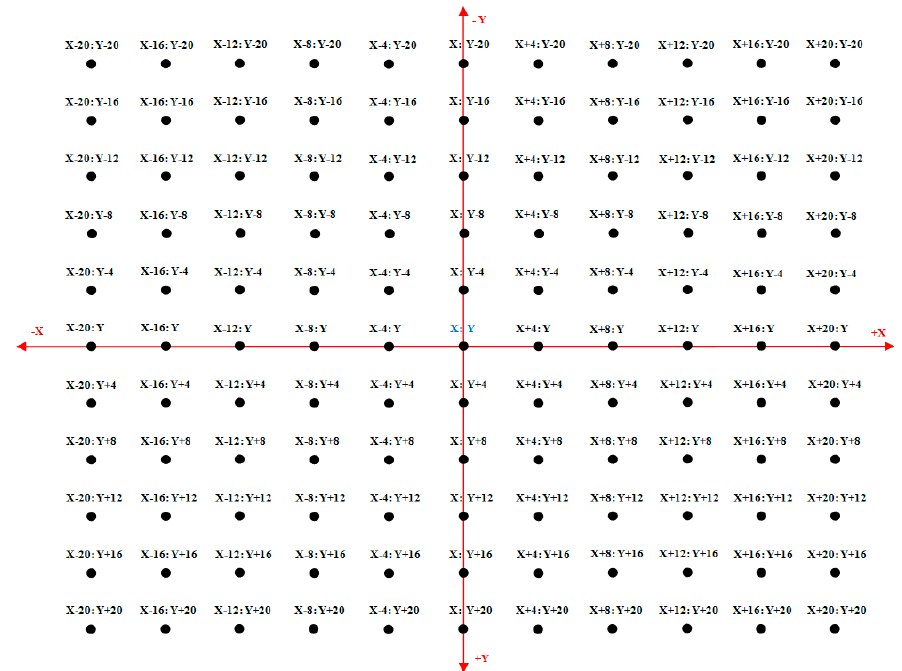
Figure 1. Locations of different particles (starting point coordinates) generated around tracked object location (X:Y coordinates) in the last frame.